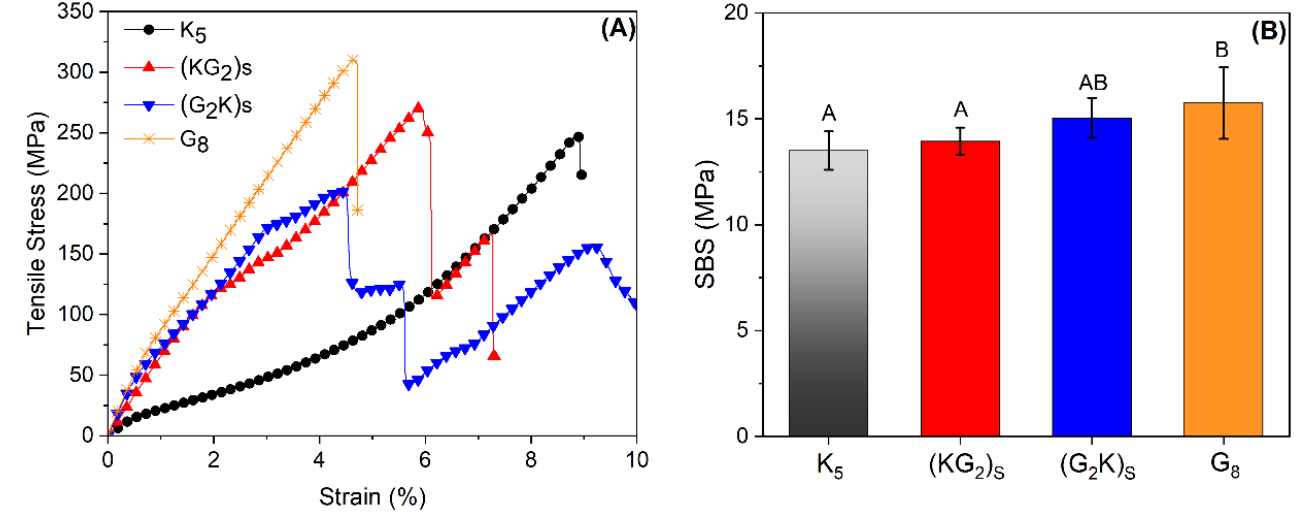
Figure 5. Typical tensile stress-strain curves ( A ) and short beam results for samples ( B ).